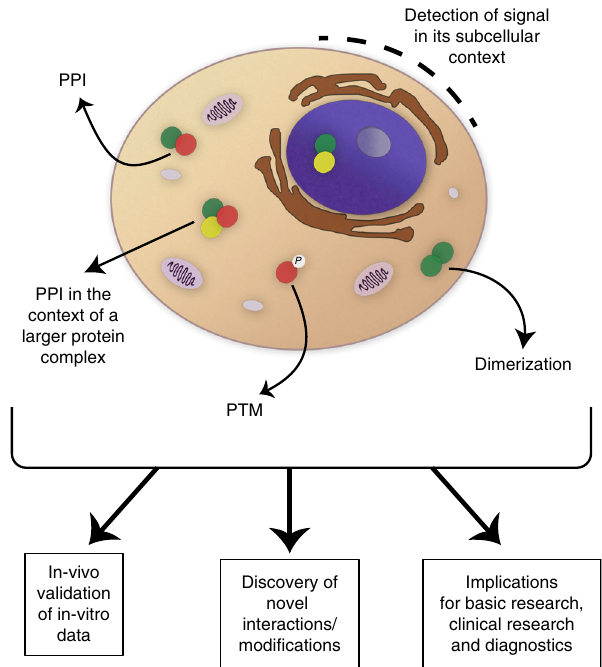
Fig. 5 Graphical scheme illustrating the various applications of PLIC. PPI protein – protein interaction, PTM post-translational modi fi